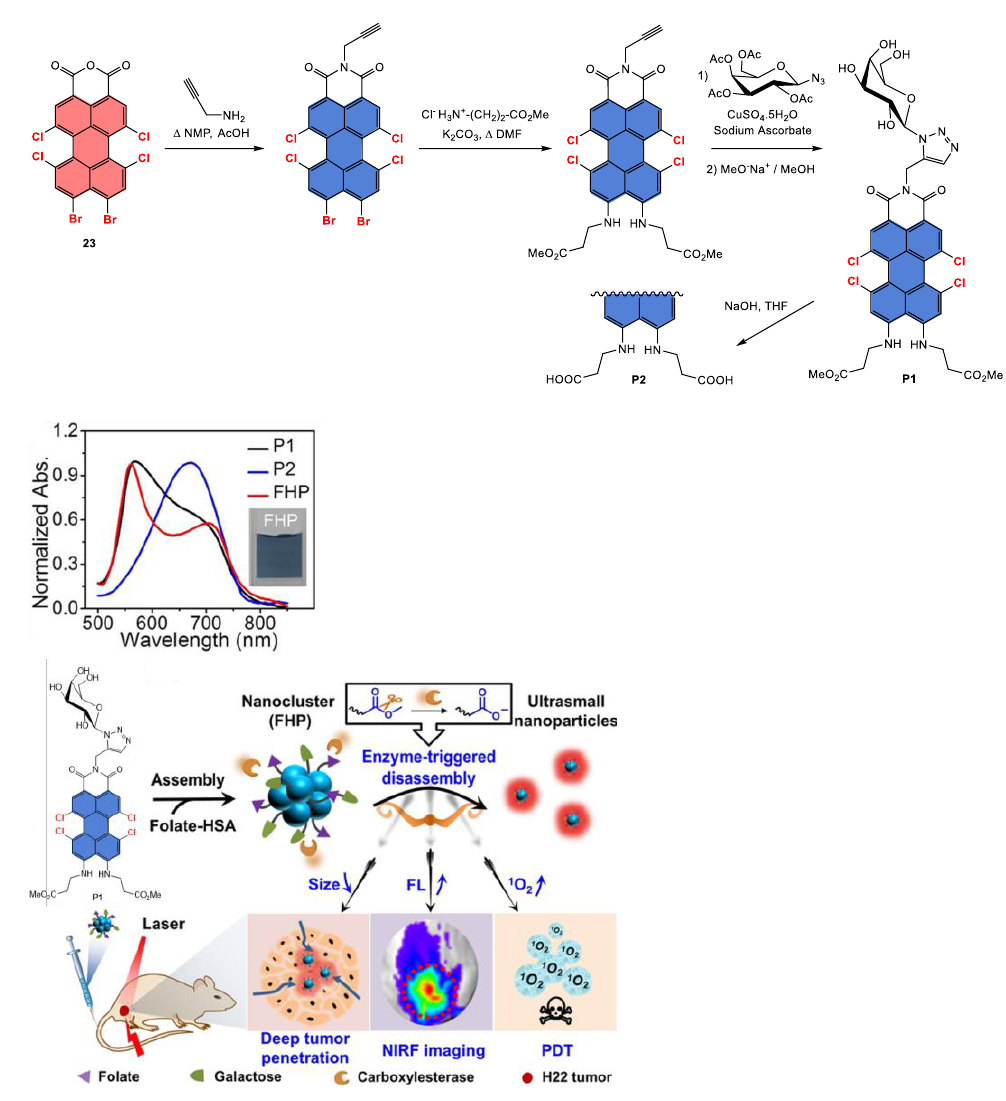
Figure 35. Synthesis of PMI derivatives decorated with a galactose unit and their normalized absorption spectra; illustrations of FHP-nanocluster fabrication, enzyme-triggered disassembly for deep-tumour penetration, near-infrared fluorescence imaging and photodynamic therapy. Adapted and reprinted with permission from reference [154]. Copyright 2020 Wiley-VCH GmbH.